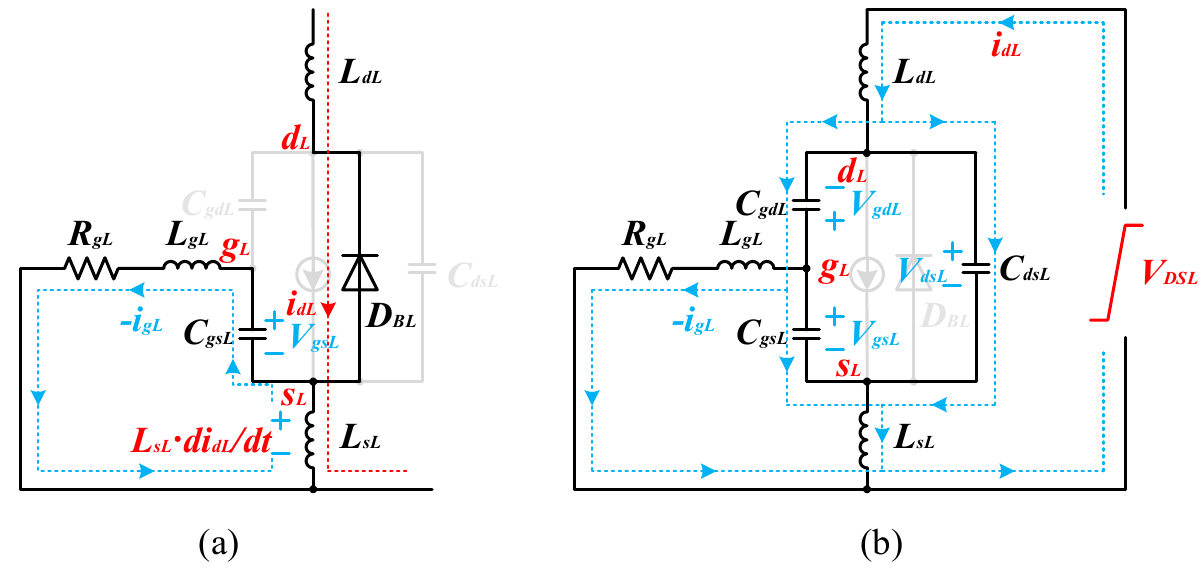
Figure 4. Equivalent circuit of Q L for crosstalk analysis during turn-on process. ( a ) current decrease stage. ( b ) voltage rise stage.